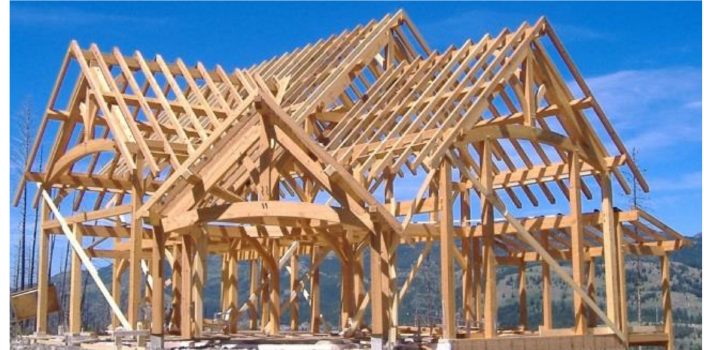
Figure 2. Column construction system [54].